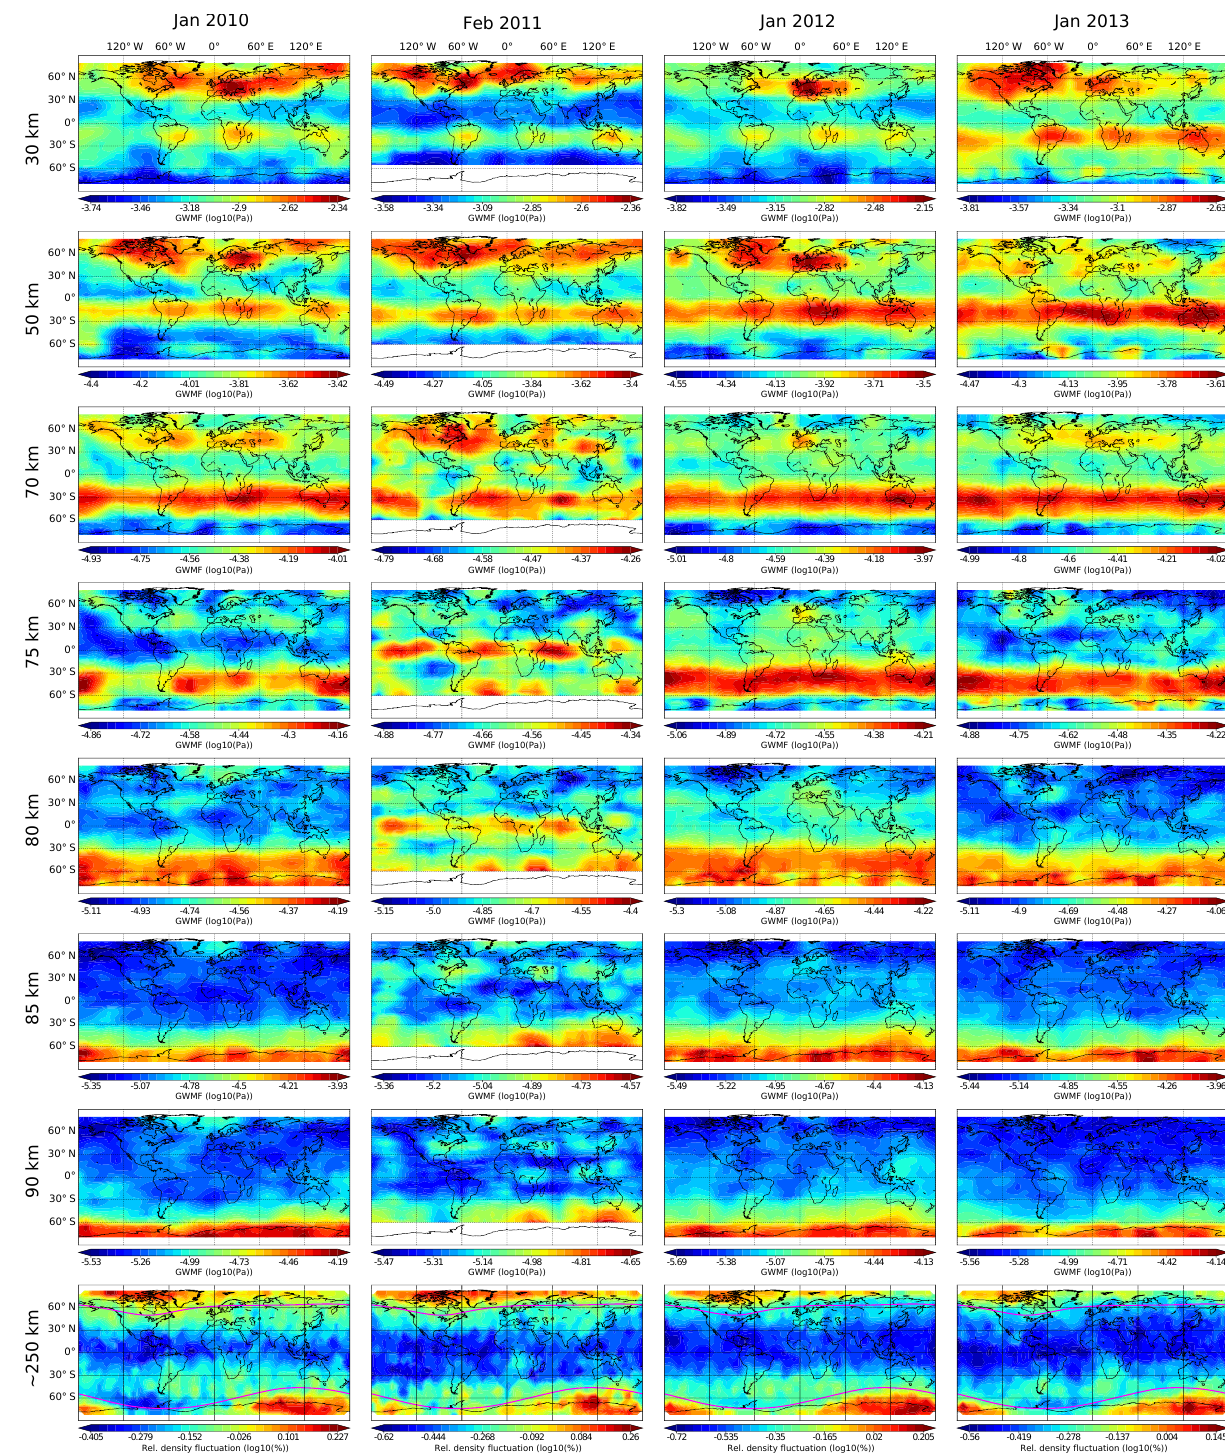
Figure 4. Same as Fig. 2 but for austral summer.